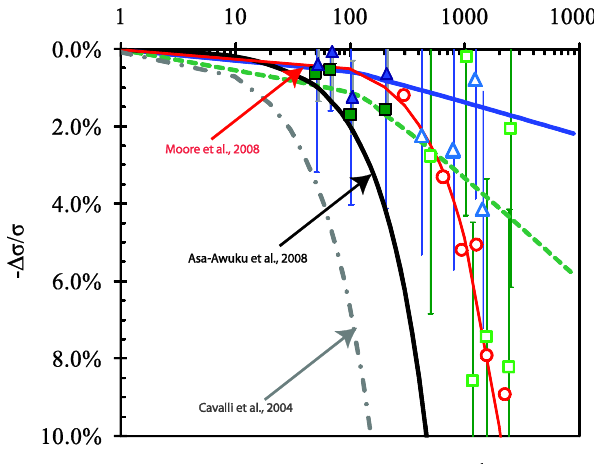
Figure 3. Surface tension depression as a function of dissolved carbon concentration. Measurements (closed symbols) and Inferred values (open symbols) of the CR (blue triangles) and SC aerosol (green squares) are shown as data points. For comparison, curves are added with data from freshly emitted biomass burning aerosol (solid black; [43], marine organic aerosol (grey dash-dot; [54]) and dissolved marine organic matter (solid red;